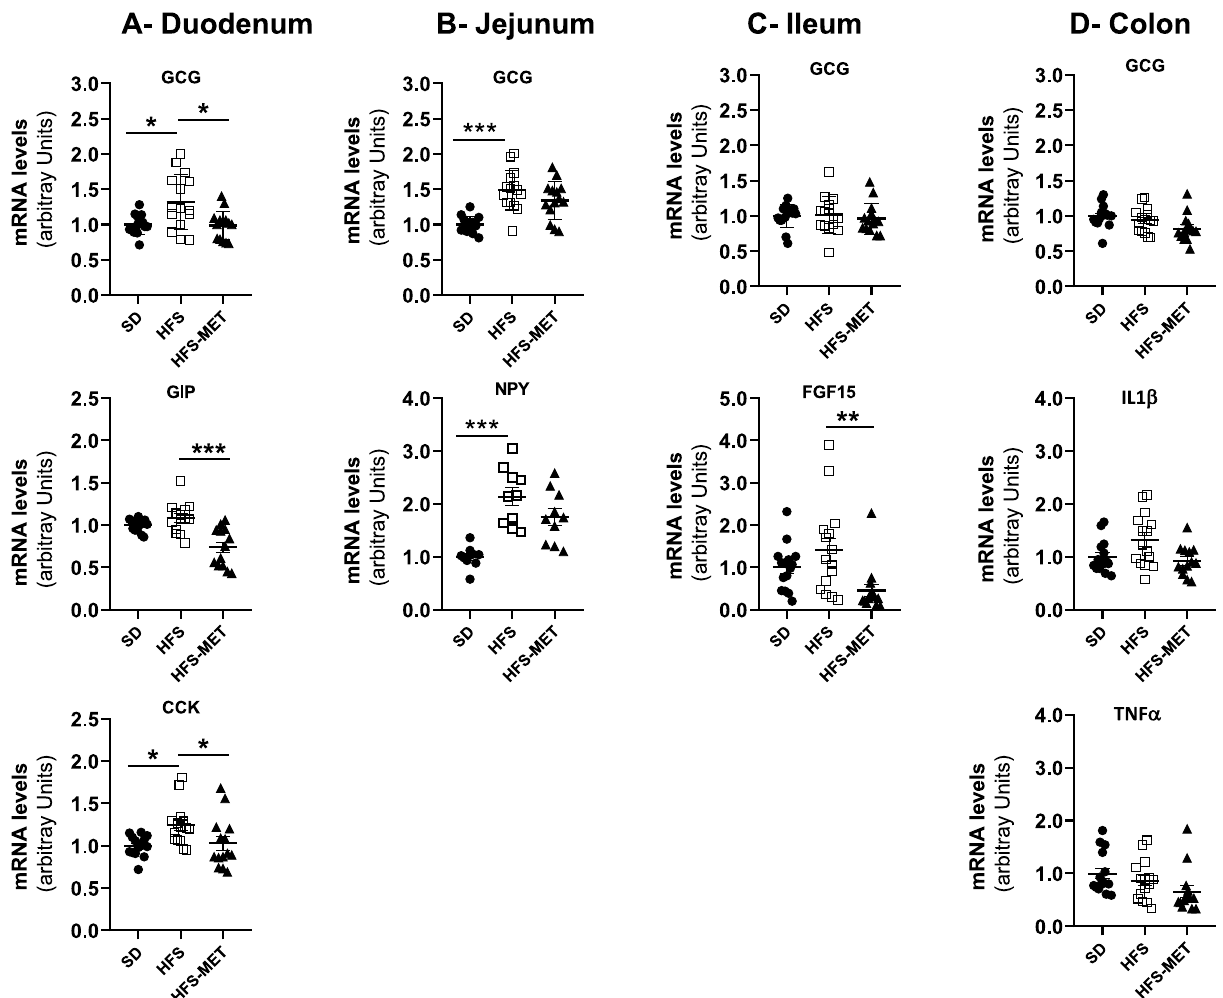
Figure 4. Effects of HFS diet and metformin treatment on the expression of intestinal hormones and peptides in the different regions of the intestine. The mRNA levels of the targeted genes were determined by RT-qPCR in ( A ) the duodenum, ( B ) jejunum, ( C ) ileum and ( D ) colon of 15 to 18 mice per group ( SD standard diet, HFS high fat high sucrose diet, HFS-MET HFS diet with metformin supplementation). *p < 0.05, **p < 0.01, ***p < 0.001, determined by ANOVA followed by Tukey’s multiple comparison